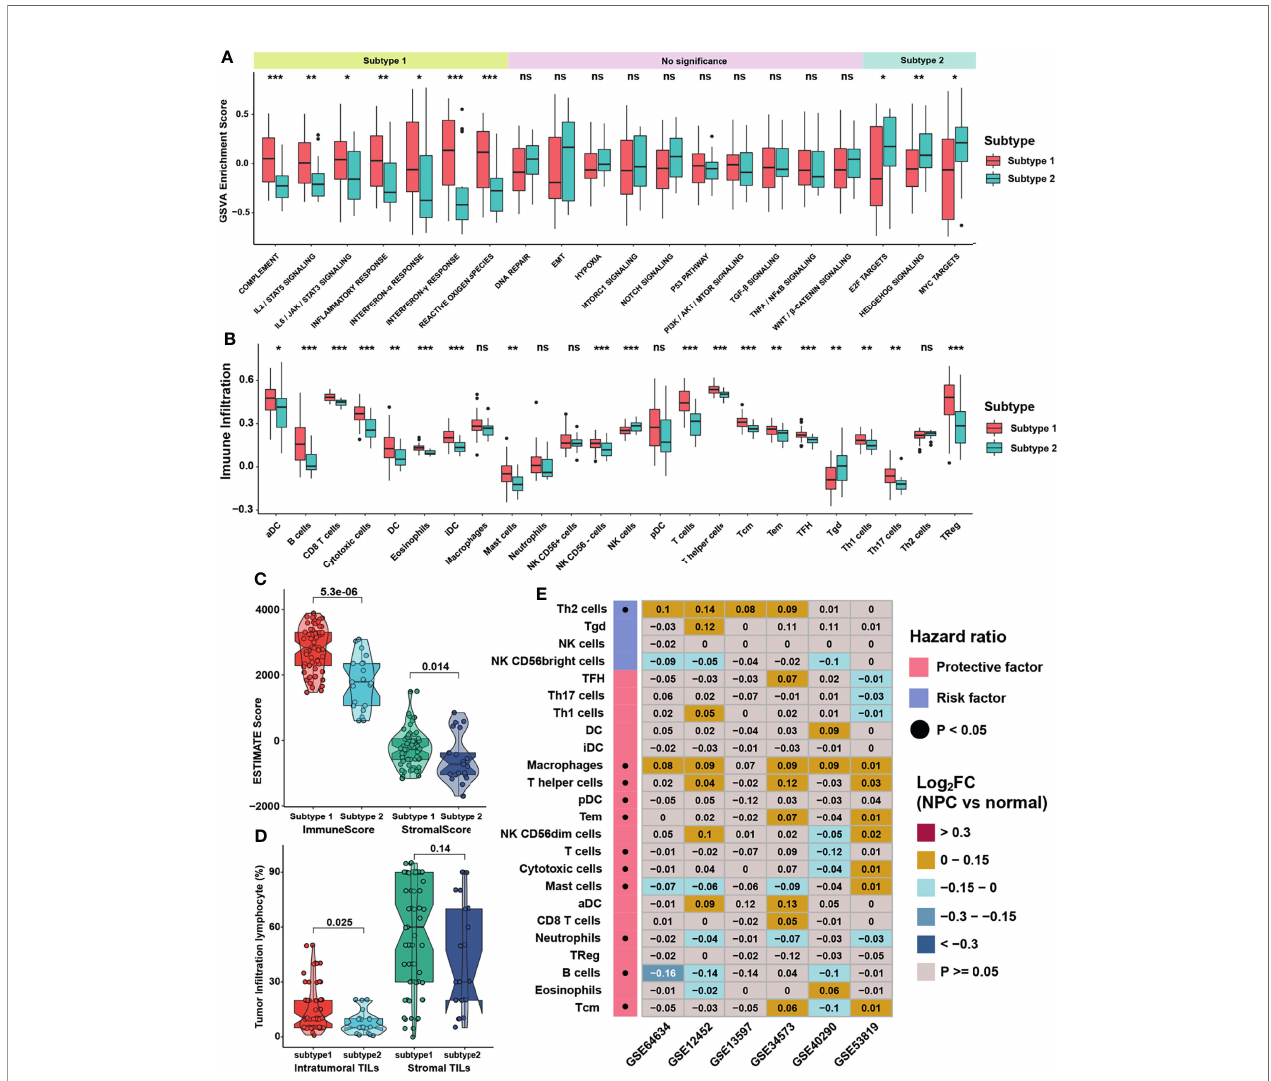
FIGURE 4 | Immune cell in fi ltration characteristics in distinct m6A subtypes. (A, B) The abundance of GSVA score for curated pathways and TME in fi ltration cell in m6A subtypes. The upper and lower ends of the boxes represented interquartile range of values. The lines in the boxes represented median values, and black dots showed outliers. (C) Differences in immune and stromal scores via ESTIMATE between m6A subtypes. (D) Differences in intratumor and stromal tumor in fi ltration lymphocytes provided in GSE102349 between m6A subtypes. (E) Differentially expressed analysis for TME in fi ltration in 6 independent datasets, and black dots in left columns represented P < 0.05. The asterisks represented the statistical p-value (*P < 0.05; **P < 0.01; ***P < 0.001) in panels (A, B) . ns, no signi fi